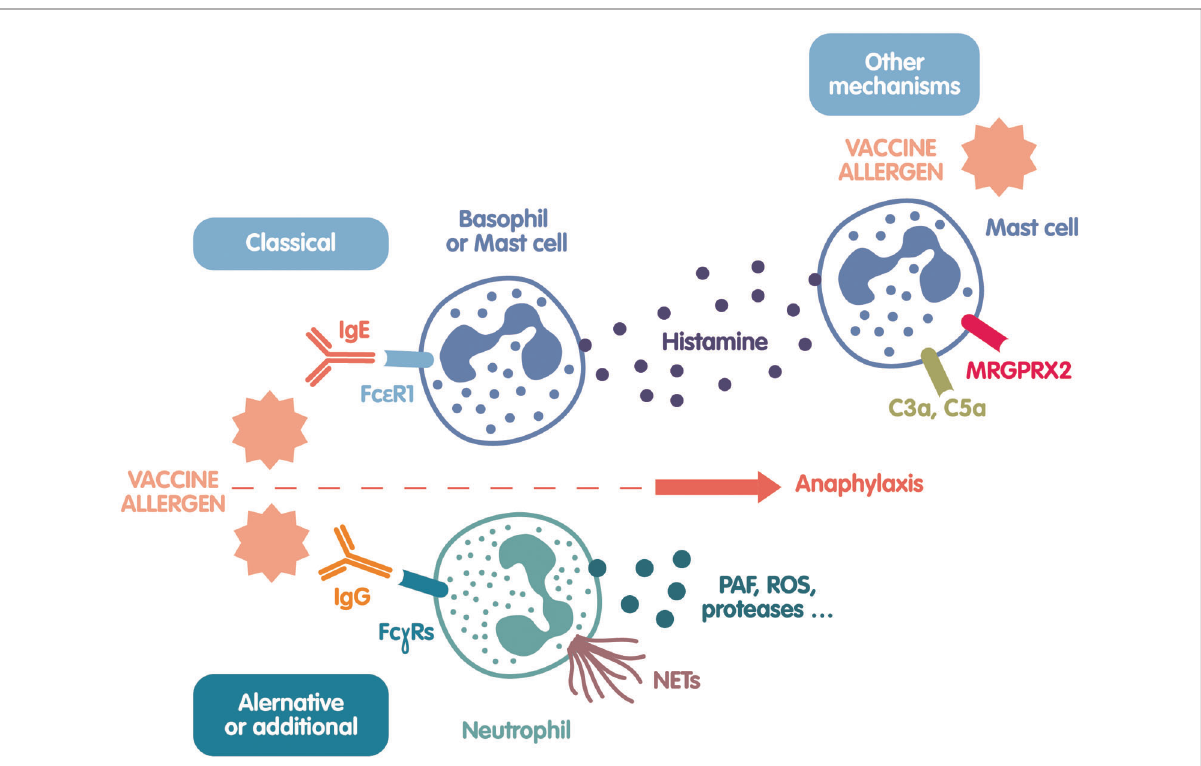
FIGURE 1 Legend. Main mechanisms of potential COVID-19 vaccine-induced hypersensitivity. The classical mechanism involves speci fi c IgE-dependent mast cell and basophil activation leading to histamine/tryptase release. The alternative or additional mechanism involves speci fi c IgG-dependent neutrophil activation leading to the release of reactive oxygen species (ROS), proteases such as elastase or neutrophil extracellular traps (NETs). Finally, several other mast cell activation mechanisms are suspected to play a role via C3a or C5a fi xation to their receptors, or via the direct activation of MRGPRX2 by the